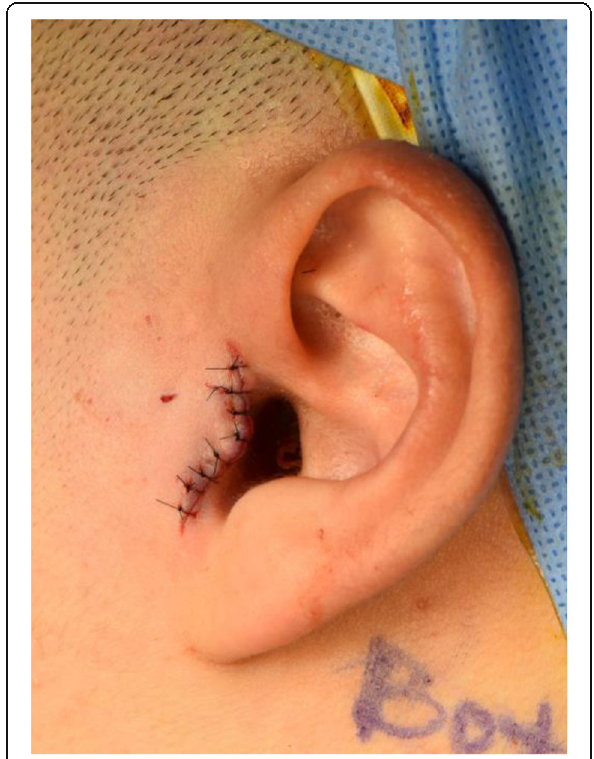
Fig. 9 Final flap repositioning and placement of 8 No. 6-0 nylon single interrupted